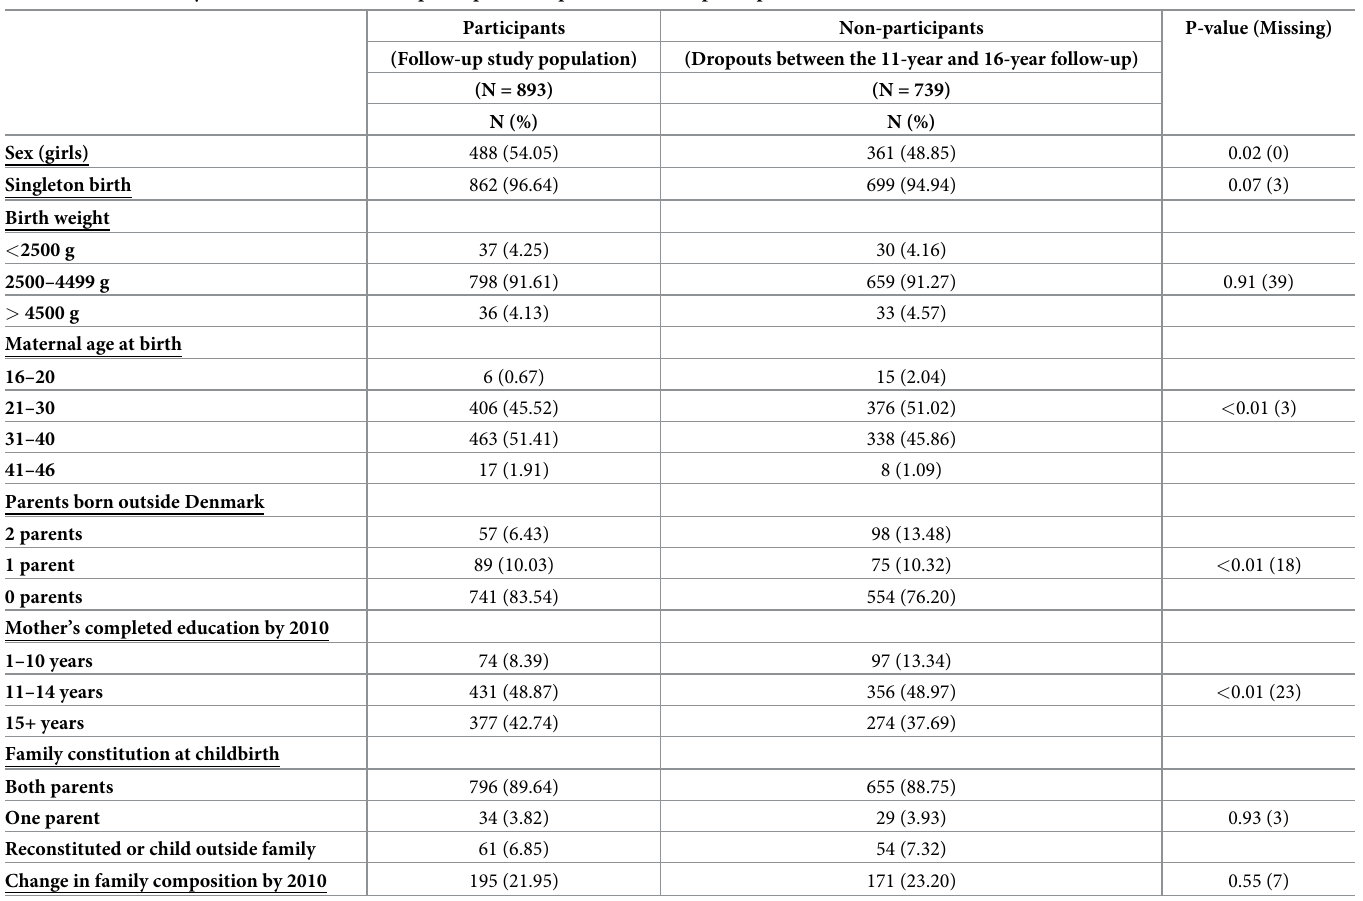
Table 1. Attrition analysis—characteristics of the participants compared to the